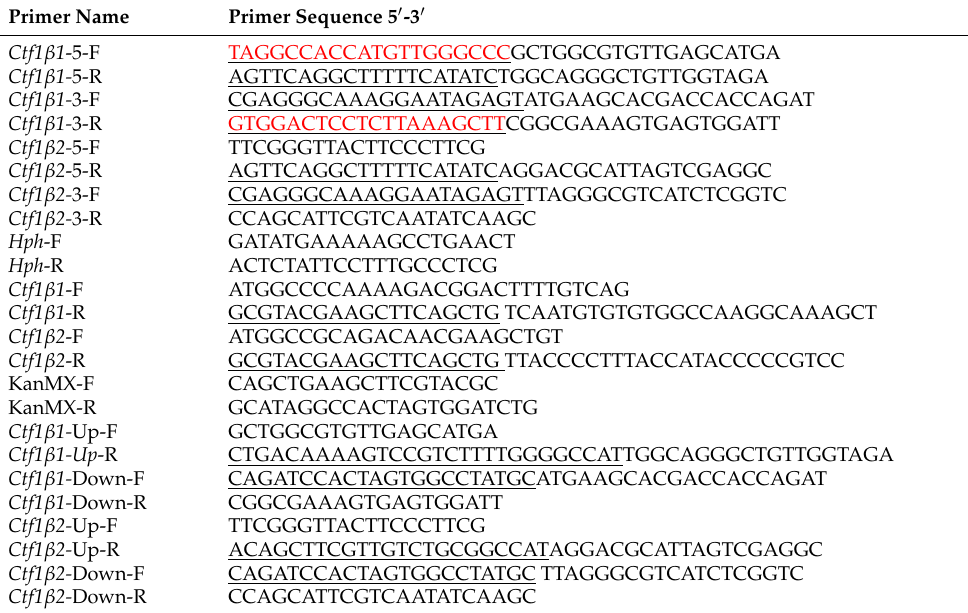
Table 3. Ctf1 β 1 and Ctf1 β 2 Gene knockout and complement experiment